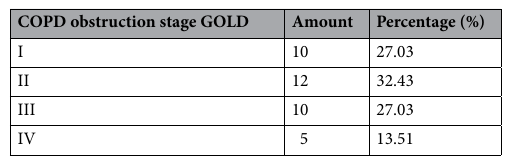
Table 2. Characteristics of COPD patients stage of obstruction